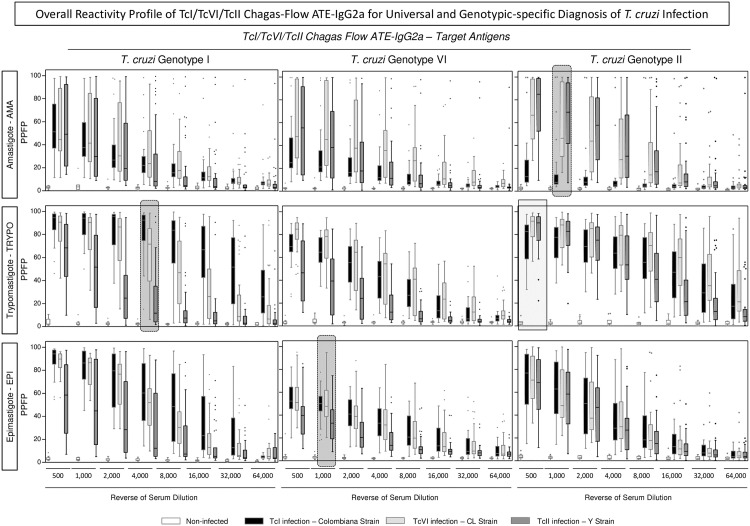
Overall reactivity profile of TcI/TcVI/TcII Chagas-Flow ATE-IgG2a for universal and genotypic-specific diagnosis of T. cruzi infection.The Chagas-Flow ATE-IgG2a reactivity was determined for sera samples from T. cruzi-infected mice, including TcI/TcVI/TcII genotype-representative strains, including: TcI/Colombiana strain (black dotted frame, n = 29), TcVI/CL strain (light gray dotted frame, n = 29) and TcII/Y strain (dark gray dotted frame, n = 35) as well as non-infected mice (white dotted frame, n = 10). Genotype-specific IgG2a reactivity to each target-antigen (amastigote-AMA, trypomastigote-TRYPO and epimastigote-EPI) from T. cruzi genotype I (left panels), genotype VI (middle panels) and genotype II (right panels) was assessed at eight serum dilutions (1:500 to 1:64,000). The results are expressed as the percentage of positive fluorescent parasites (PPFP), using the box plot format, stretching from min to max values with outliers represented by gray-shaded dots and the box defining the 25th and 75th percentile and the median value (line across the box). Comparative analyses were performed by the Kruskal-Wallis followed by Dunn’s post test for multi-group comparisons. Significant differences were considered at p<0.05. The light gray continuous rectangle selects the pair of attributes (“target antigen/serum dilution”) with the most consistent ability to discriminate non-infected mice from all T. cruzi-infected hosts (Colombiana, CL and Y strains). Therefore, these features (anti-TcII TRYPO reactivity at 1:500) were selected for universal diagnosis of T. cruzi infection. The dark gray dotted frame select the pair of attributes “target antigen/serum dilution” with the most promising perspective to distinguish the reactivity of sera samples amongst host infected with Colombiana, CL or Y T. cruzi strains. Therefore, these features (anti-TcII AMA reactivity at 1:1,000; anti-TcI TRYPO reactivity at 1:4,000 and anti-TcVI EPI reactivity at 1:1,000) were selected for genotype-specific diagnosis of T. cruzi infection.